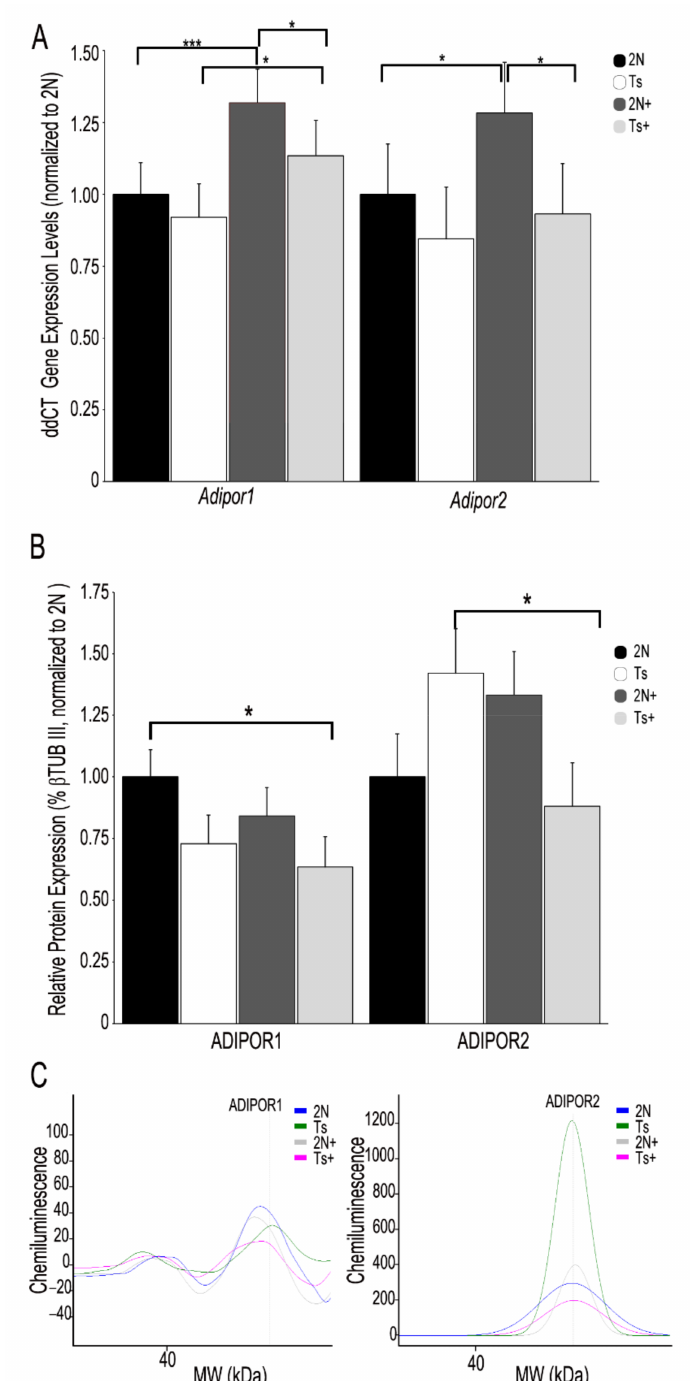
Figure 2. Gene and encoded protein levels of APN receptors ADIPOR1 and ADIPOR2 in the Fr Ctx of Ts65Dn mice and 2N littermates in relation to MCS. ( A ) Adipor1 and Adipor2 relative PCR product expression (normalized to 2N; ddCT with Rn45s as housekeeping gene) revealed no significant differences by genotype. A significant increase in Adipor1 and Adipor2 was found in 2N mice due to MCS. A significant increase in Adipor1 was also found in Ts mice due to MCS. PCR product levels were significantly higher in 2N+ offspring compared to Ts+ offspring. ( B ) A significant decrease in ADIPOR1 was found in Ts+ offspring compared to 2N untreated animals. A significant decrease in ADIPOR2 was found in Ts mice due to MCS. ( C ) Representative digital signatures of each assayed protein raw expression levels (y-axis) and molecular weight (x-axis) from 2N, Ts, 2N+ and Ts+ Fr Ctx tissue homogenates. Key: Error bars = SEM; * p < 0.05, *** p <